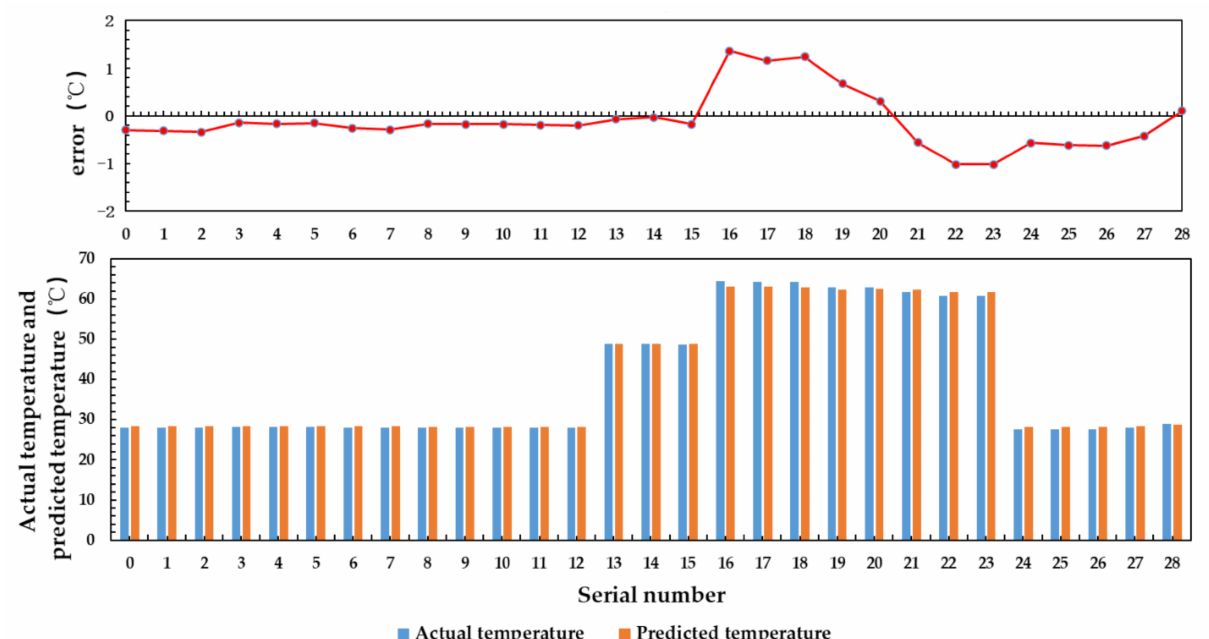
Figure 28. BP neural network inversion result.